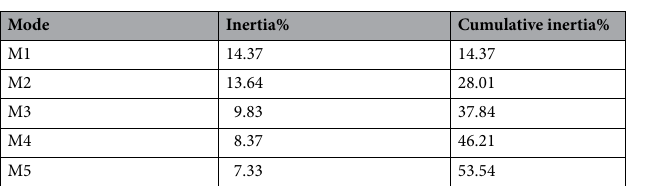
Mode Inertia% Cumulative inertia%